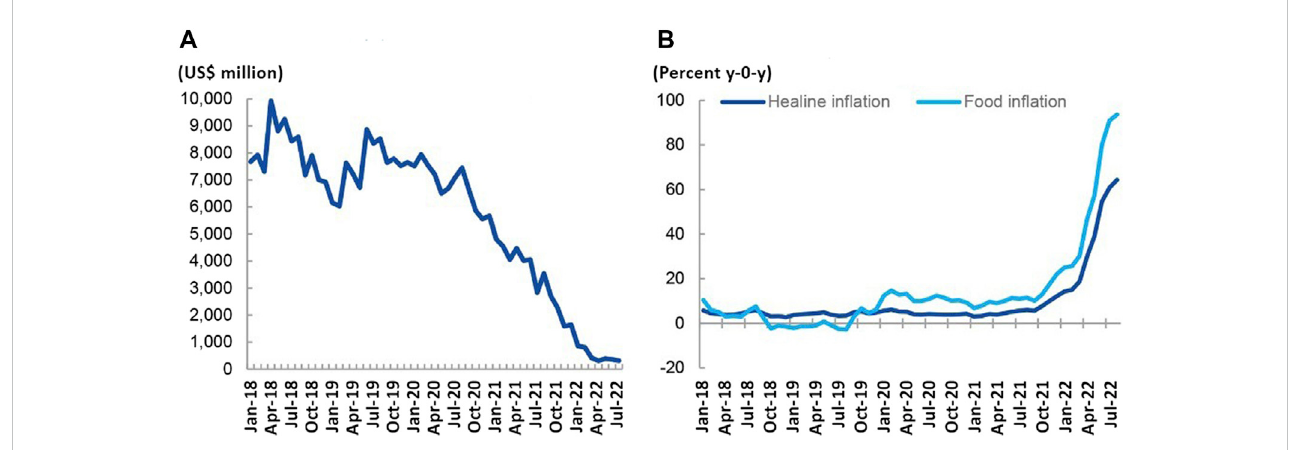
FIGURE 1 (A) Grossof fi cialreservesofSriLankafromJanuary2018toJuly2022(ThisexcludesacurrencyswapthattranspiredbetweentheSriLankangovernment and the People ’ s Bank of China in early 2022) (B) In fl ation (Colombo Consumer Price Index) from January 2018 to July 2022 (World Bank,